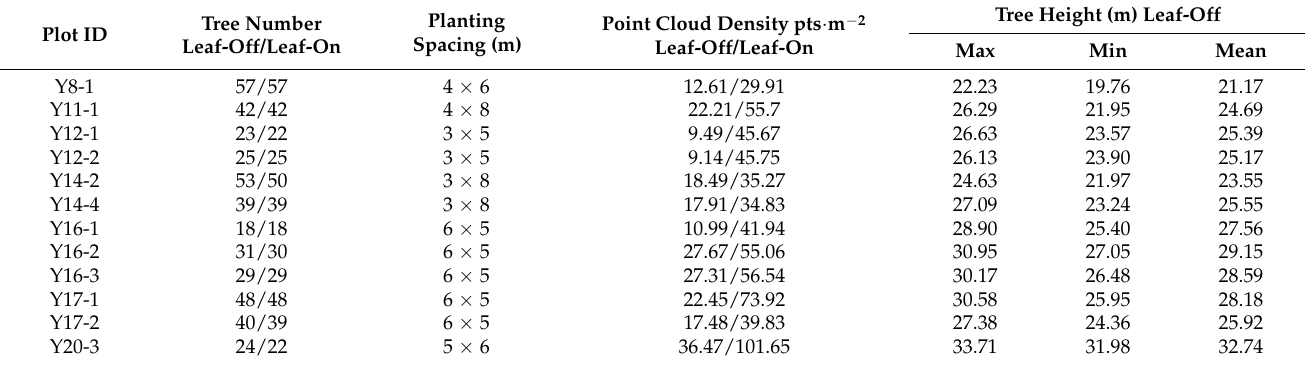
Figure 2. Examples of UAV-LiDAR data in leaf-off and leaf-on conditions. ( a ) Eleven stand age poplar plantation plots from the leaf-off season; ( b ) seventeen stand age poplar plantation plots from the leaf-off season; ( c ) eleven stand age poplar plantation plots from the leaf-on season; ( d ) seventeen stand age poplar plantation plots from the leaf-on season. Table 1. Descriptions of poplar plot per site